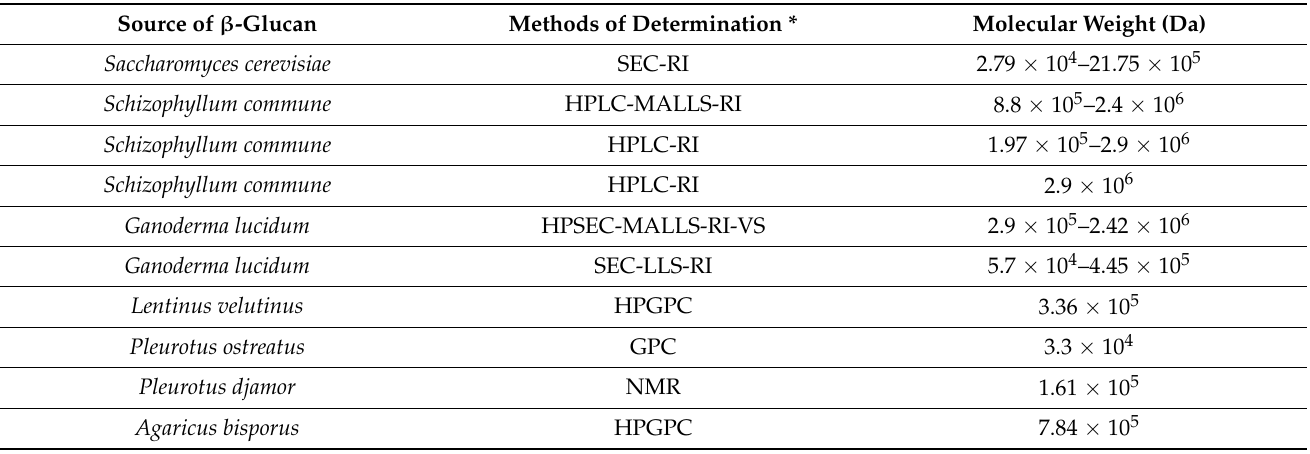
Table 2. Molecular weights of different glucans determined by several methods (or by a combination of methods)